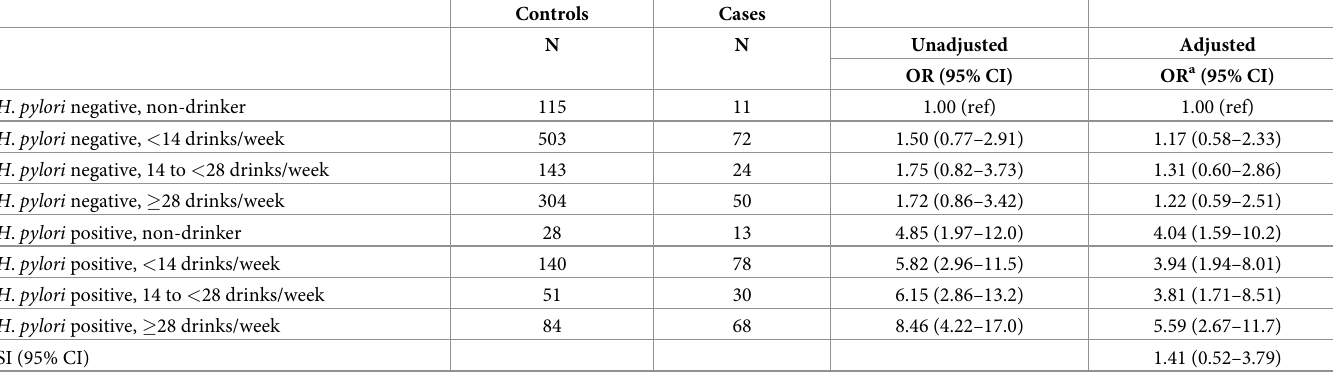
Table 4. Association of combined alcohol and H . pylori infection exposure and risk of gastric intestinal